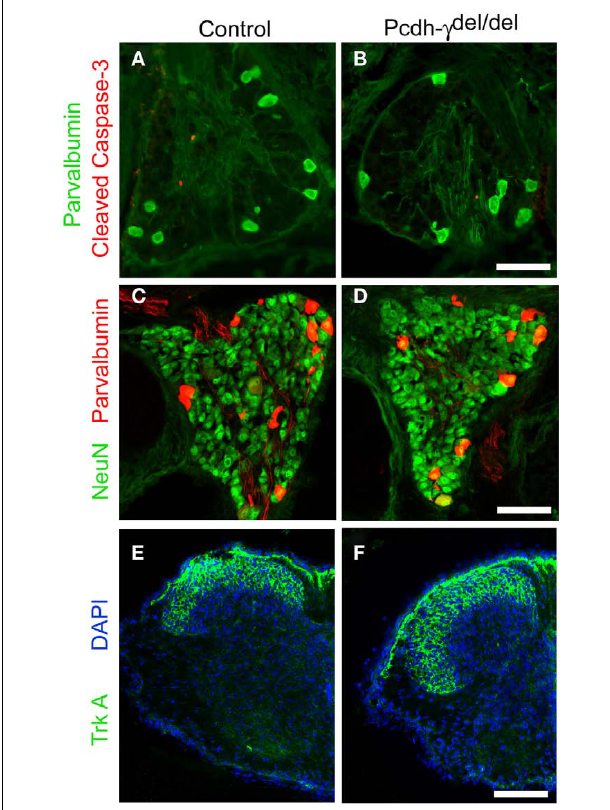
FIGURE 2 | Normal survival and differentiation of DRG sensory neurons in Pcdh- γ null mutants. DRGs from P0 control and Pcdh- γ del/del mice were immunostained with antibodies against cleaved caspase-3 [red; (A,B) ] or against the neuronal marker NeuN [green (C,D) ], along with those against the Ia neuron marker parvalbumin [green, (A,B) ; red, (C,D) ]. No excessive apoptosis of mutant sensory neurons was observed and the neuronal density, Ia neuron number, and overall size of mutant DRGs are all similar to controls. (E) P0 Control and (F) Pcdh- γ null mutant spinal cords stained with antibodies againstTrkA + cutaneous sensory axons indicate that these terminate normally in the superficial part of the dorsal horn in the absence of the γ -Pcdhs. Scale bar: 50 μ m in (A–D) ; 100 μ m in (E,F)